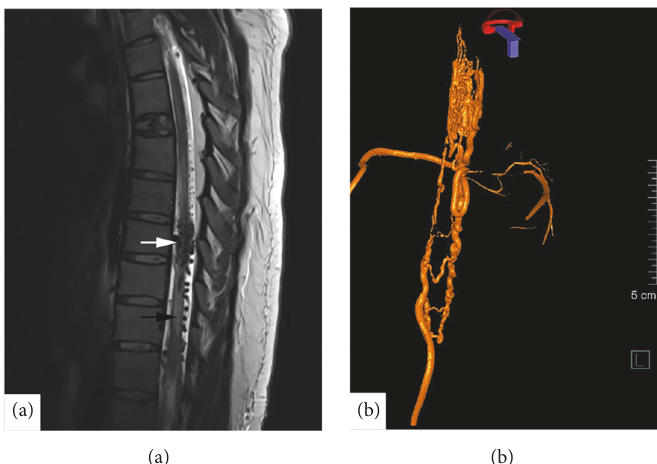
Figure 1: (a) Lateral T2-weighted MRI thoracic spine showing peri- and intramedullary spinal AVM at T8 (white arrow) with surrounding spinal cord oedema T6-T11 (black arrow). (b) Left lateralthree-dimensional rotational spinal angiography (3D-RSA) from rightT9 intercostal artery showing spinal cord